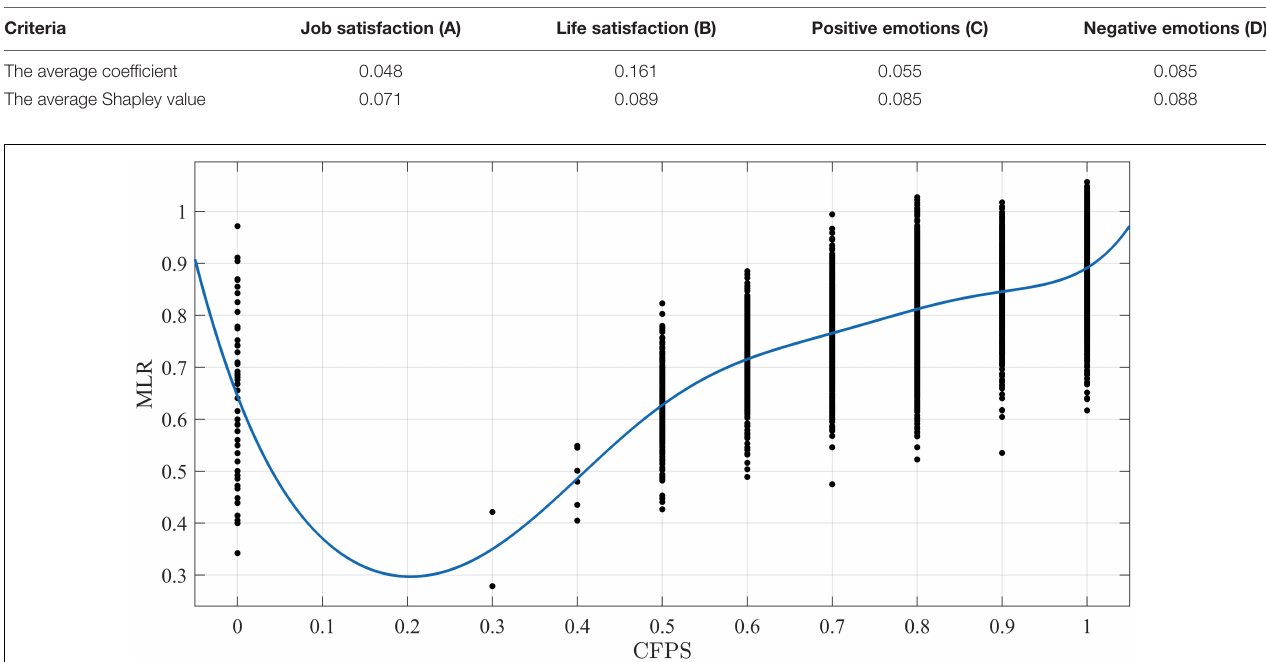
TABLE 7 | The average Shapley value and coefficient of four criteria.